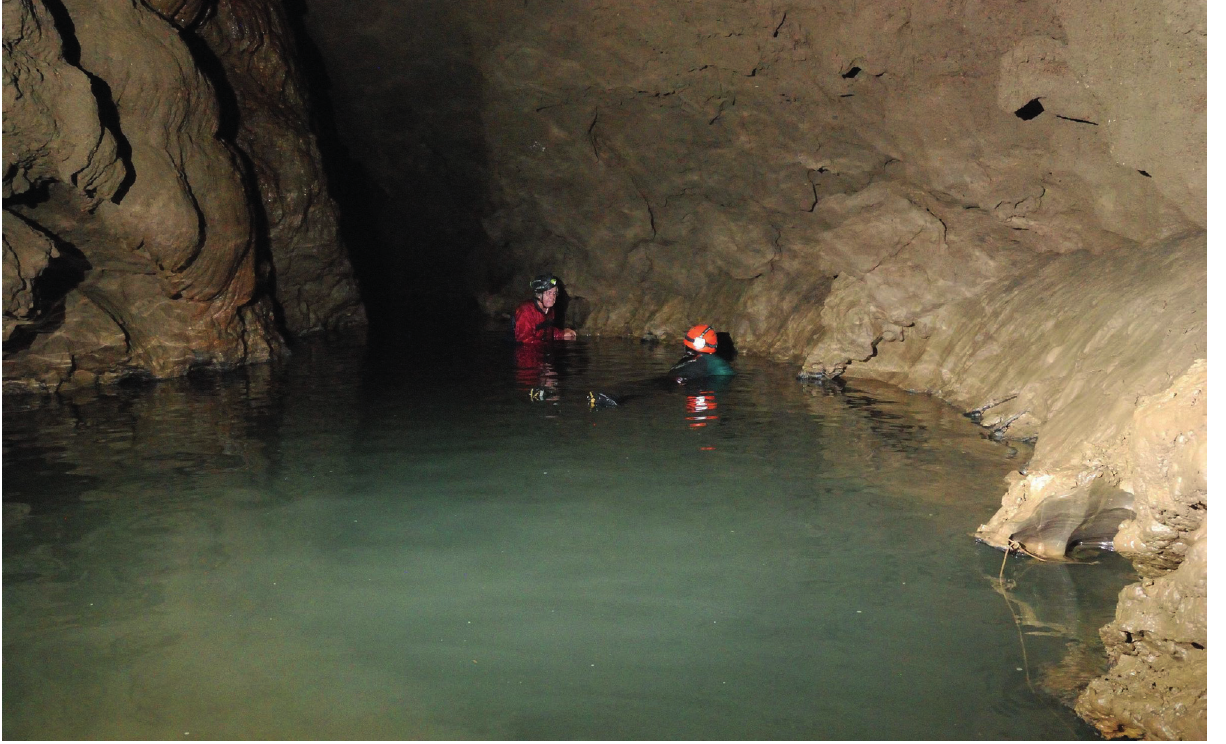
Figure 3. Visual search for aeglids in shallow areas near margins of the subterranean lake (partial view). Photo by Alexandre L.